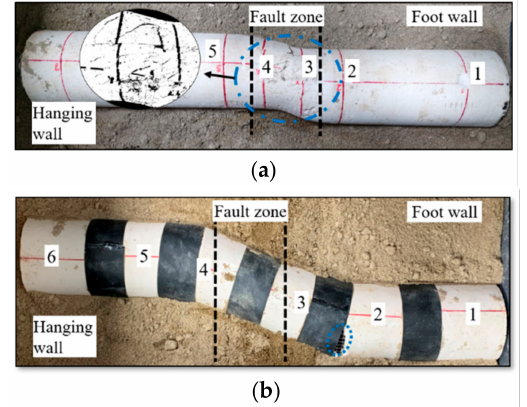
Figure 7. Damage pattern of the tunnel. ( a ) lining without joints; ( b ) lining with